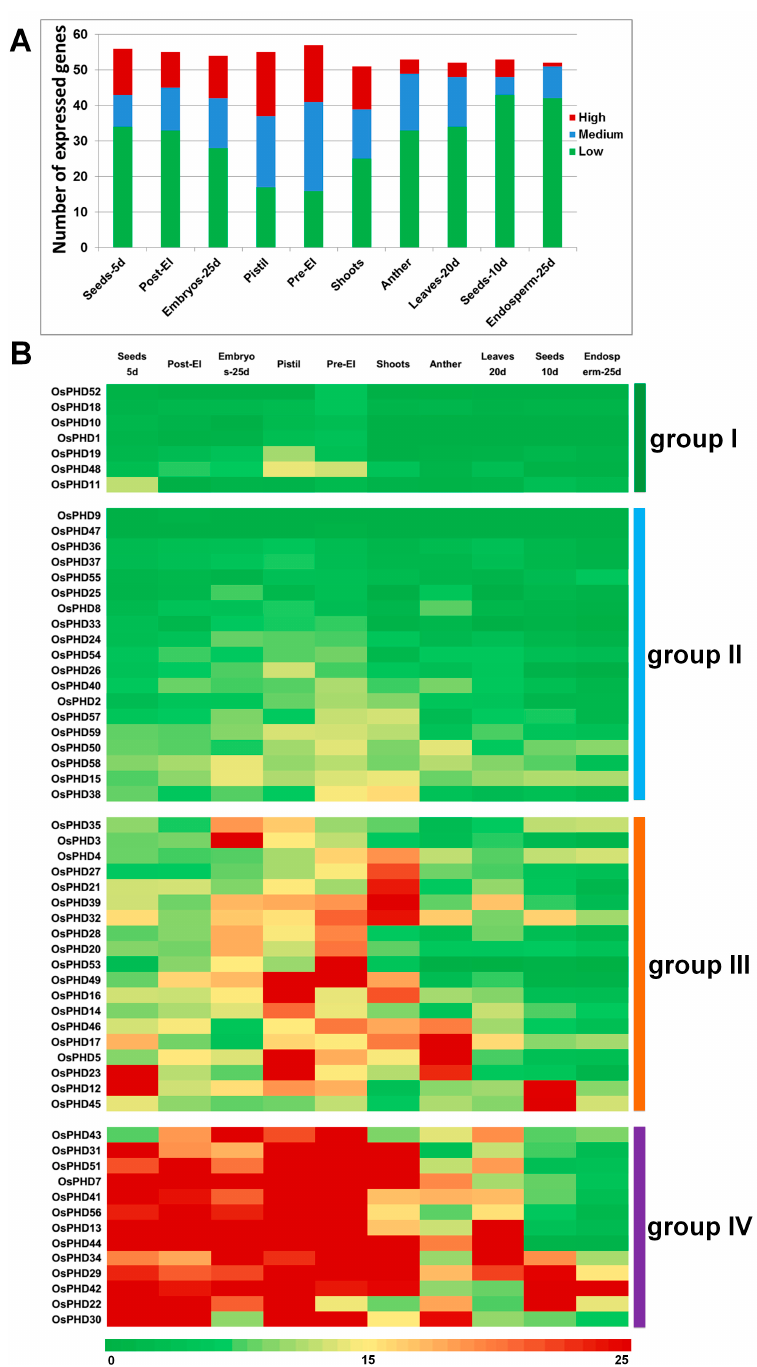
Figure 6. Expression of the rice PHD family genes in different tissues. ( A ) Numbers of expressed genes in different tissues. Expression data in different tissues were downloaded from the Rice Expression Profile Database. High: expression values >20, medium: 20 ≥ expression values >10, low: 10 ≥ expression values >0; ( B ) Expression profiles of the rice PHD family genes in different tissues. A heat map was generated and OsPHDs were manually clustered into four groups according to their expression values in different tissues. The color scale represents the expression values: red indicates high levels and green represents low levels. Pre-EI: pre-emergence inflorescence; Post-EI: post- emergence inflorescence.